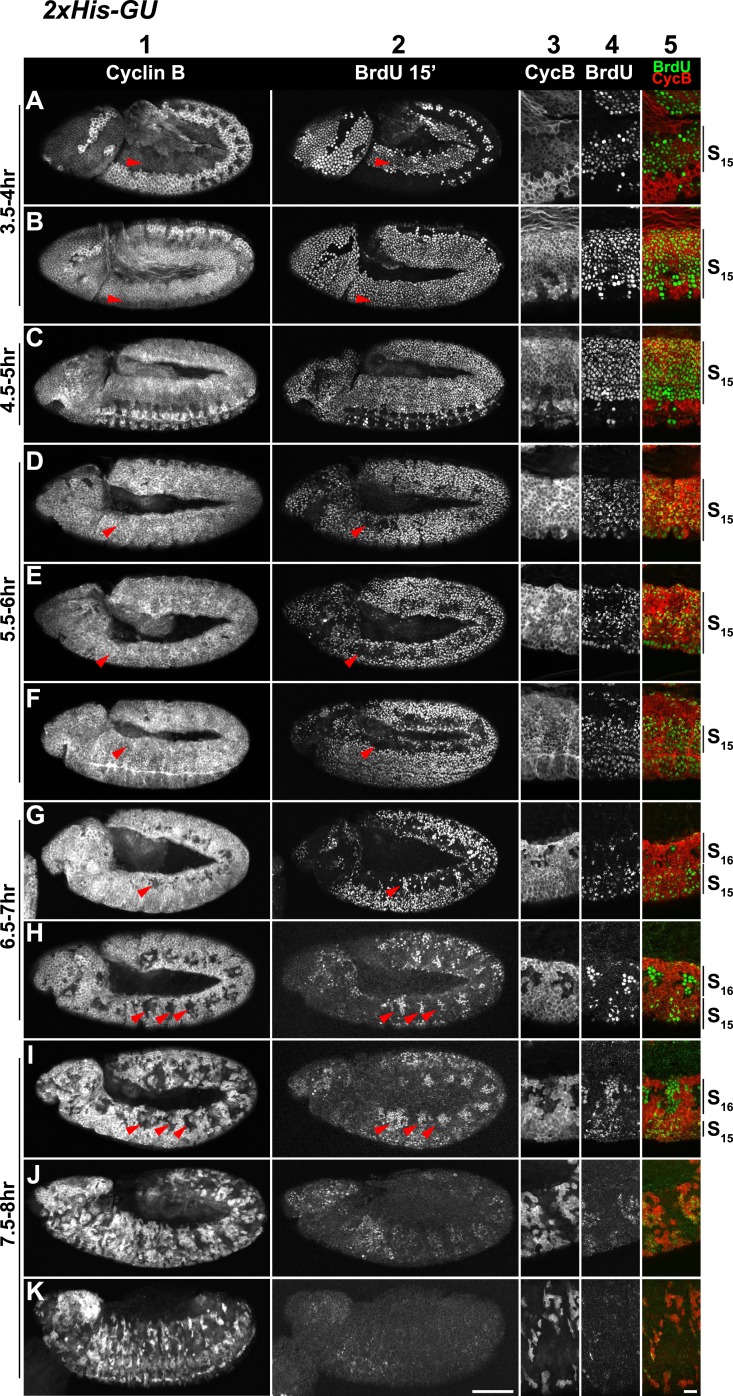
Cell cycle progression of HisC mutant embryos with two His-GUs (2xHis-GUs).Shown are representative time-matched (as indicated on the left) embryos that were incubated with BrdU for 15′ immediately before fixation and staining with antibodies against Cyclin B and BrdU, respectively. BrdU incorporation visualises DNA replication and Cyclin B degradation is a marker for mitosis (Figure 1A). Columns 1–2 show the Cyclin B and BrdU staining in whole mount embryos. Columns 3–5 are magnifications of an epidermal region with single channel detections of Cyclin B (CycB), BrdU and the merge of both channels (BrdU in green, Cyclin B in red). Magnifications are oriented with dorsal side up. We previously described experiments showing the stereotyped cell cycle progression in wild type embryos (Günesdogan et al., 2010). AEL: after egg laying, scale bars: 100 µm in columns 1–2, 10 µm in columns 3–5. 3.5–4 hr AEL: (A) dorsal epidermal cells degraded Cyclin B, completed M14 and entered S15 as shown by the incorporation of BrdU (arrowheads). (B) Ventral cells underwent M14 and entered S15 (arrowheads). Accordingly, all cells re-accumulated Cyclin B and incorporated BrdU. 4.5–5 hr AEL: (C) all epidermal cells undergo S15 and thus show Cyclin B staining and incorporation of BrdU. At this stage, dorsal epidermal cells of wild type embryos already entered M15/S16 (Figure 2C). 5.5–6 hr AEL: (D–F) dorsal epidermal cells stopped incorporating BrdU and completed S15 (arrowheads). 6.5–7 hr AEL: (G and H) dorsal epidermal cells degraded Cyclin B and entered M15 (arrowheads). Some cells already went through M15 and showed BrdU incorporation, indicating that they had entered S16 (arrowheads, G). The division pattern in wild type embryos is highly stereotyped and controlled by developmental genes. In wild type embryos, cells around the tracheal pits, which are structures in the posterior of each parasegment, enter M16 first (Figure 2D). In 2xHis-GU embryos, M15 took place at a developmental stage, when wild type embryos progressed through or completed M16 in the epidermis. Interestingly, the M15 division pattern in 2xHis-GU embryos (H) resembled the M16 division pattern in wild type embryos (Figure 2D), suggesting that the developmental program proceeds normally in 2xHis-GU embryos. 7.5–8 hr AEL: (I) after completion of M15, cells entered S16 and showed BrdU incorporation (arrowheads). (J and K) During and after germ band retraction, most epidermal cells did not incorporate BrdU, indicating that they aborted S16. Wild type embryos at this developmental stage stop to proliferate after M16 by entering a G1/0 phase (Knoblich et al., 1994). 2xHis-GU embryos apparently also enter a G1/0 phase, enforced by the ongoing developmental program.